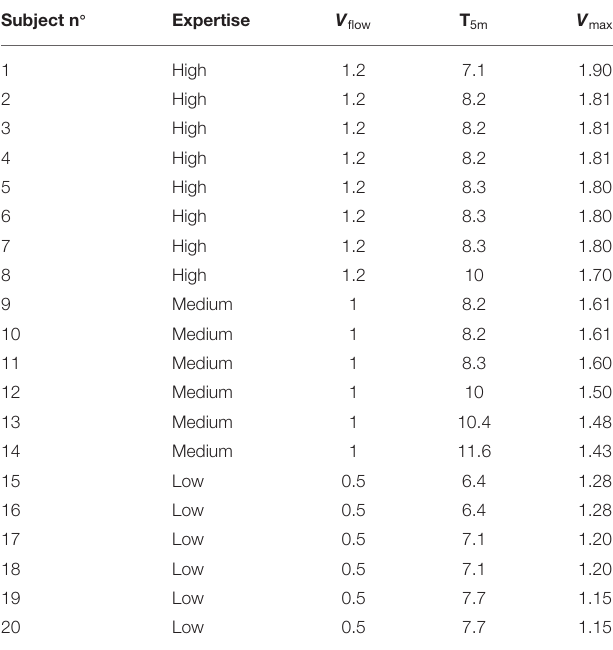
TABLE 2 | Individual values for maximum swim